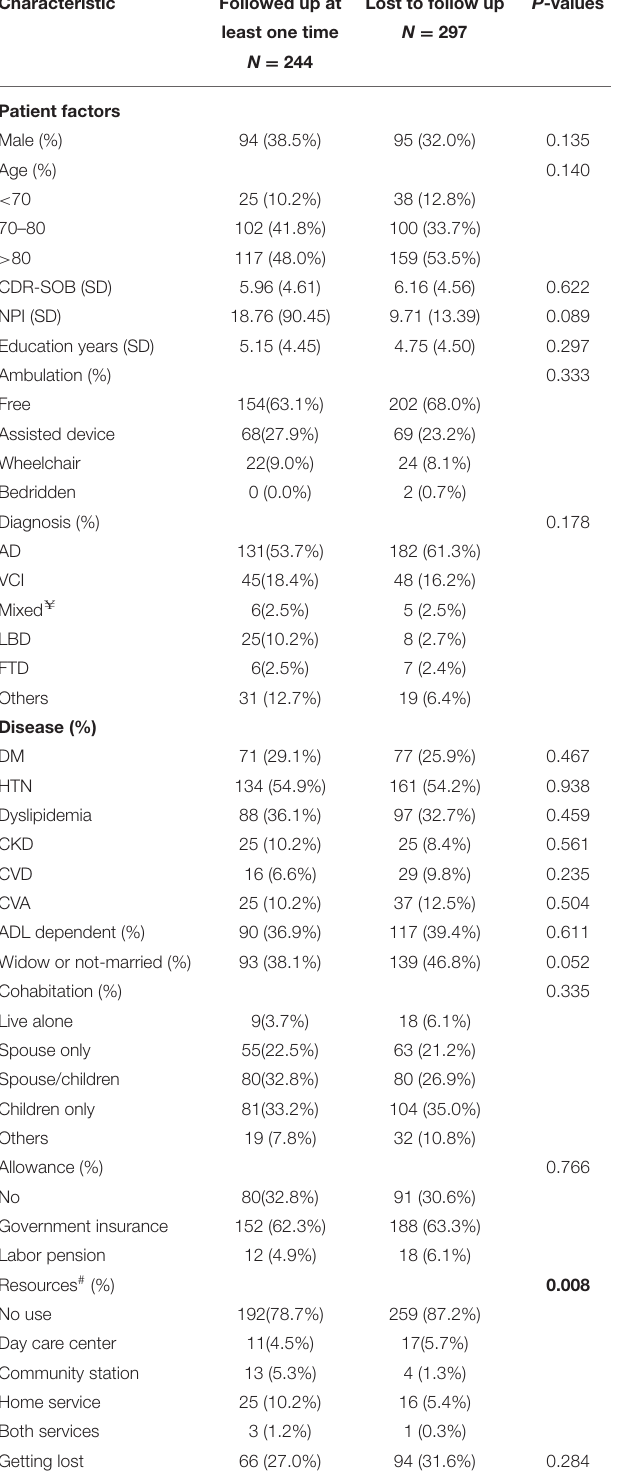
TABLE 2 | Comparison of baseline characteristics of patients and caregivers between the follow-up and lost-to-follow-up groups. Characteristic Followed up at Lost to follow up P